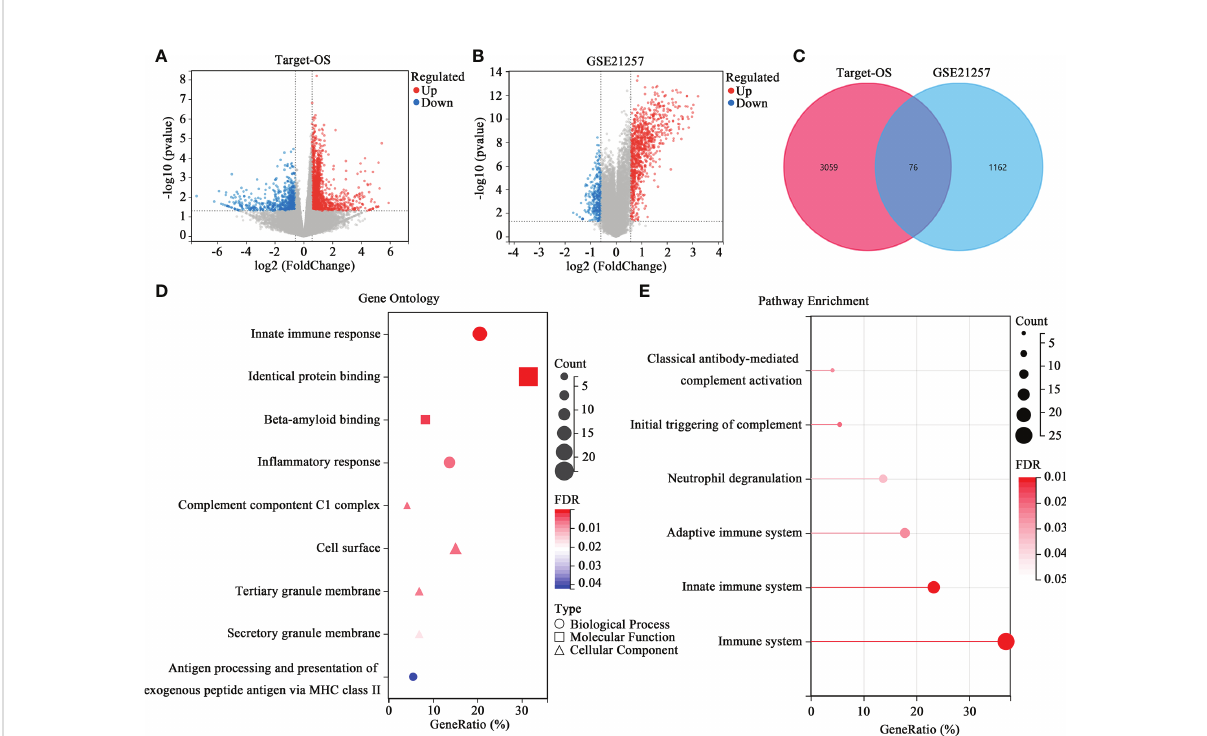
FIGURE 3 Differential expression analysis and enrichment analysis of the HBP-related prognostic model. (A, B) Volcano map of DEGs between the high- and low-risk groups in Target-OS (A) and GSE21257 (B) cohorts. (C) Venn diagram of the intersection DEGs between the Target-OS and GSE21257 cohorts. (D, E) Functional annotation of the 76 DEGs in GO function (D) and REACTOME pathway enrichment analysis (E)